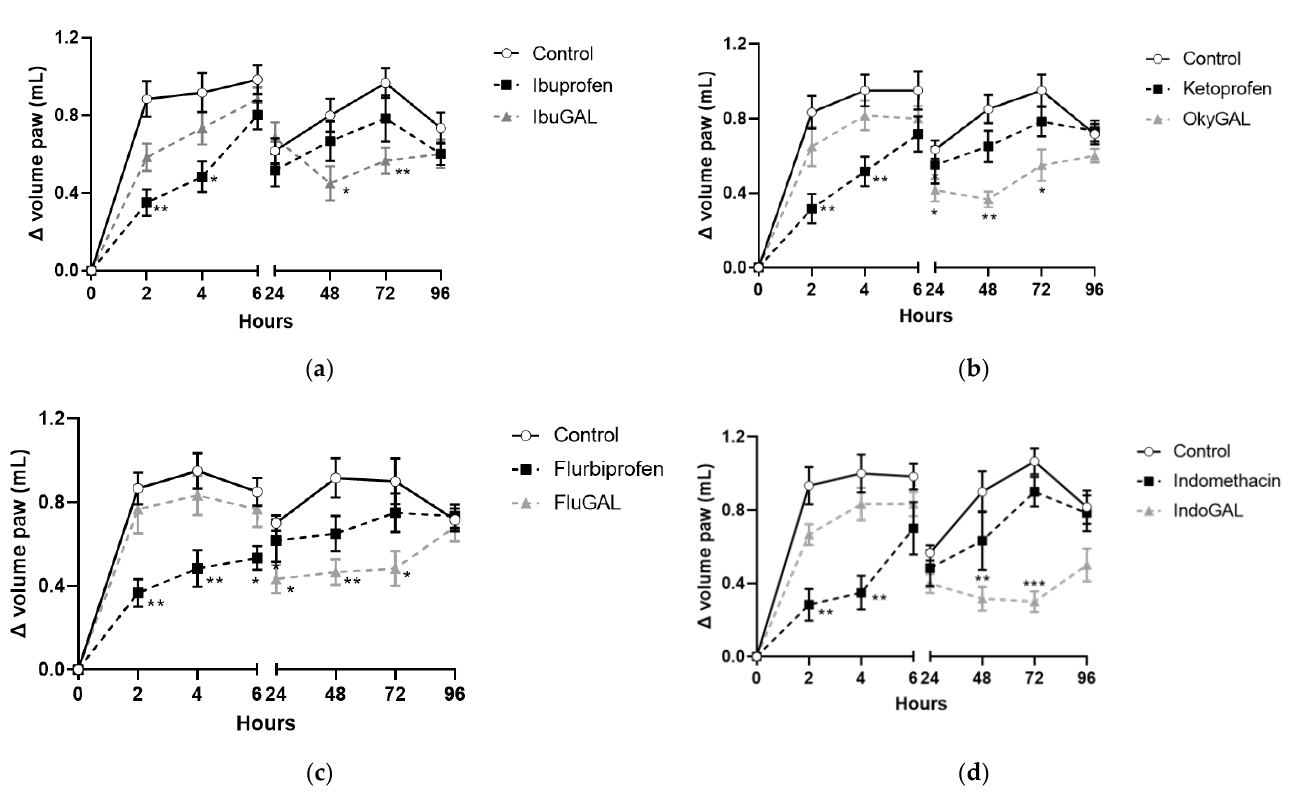
Figure 4. ( a – d ) . Effect of the parent drugs and galactosylated prodrugs on carrageenan-induced hyperalgesia. Effect of oral administration of the parent drugs ( a ) ibuprofen, ( b ) indomethacin, ( c ) ketoprofen and ( d ) flurbiprofen and the galactosylated prodrugs ( a ) IbuGAL, ( b ) IndoGAL, ( c ) OkyGAL and ( d ) FluGAL on carrageenan-induced hyperalgesia in mouse paws evaluated at 2, 4, 6, 24, 48, 72 and 96 h after the carrageenan challenge. White circles represent control mice treated with vehicle. Black squares represent mice treated with the parent drugs (ibuprofen, indomethacin, ketoprofen, and flurbiprofen) and gray triangles represent mice treated with the galactosylated prodrugs (IbuGAL, IndoGAL, OkyGAL and FluGAL). The increase in paw volume was evaluated and is expressed as the difference in paw volume measured at each time point and the basal paw volume measured immediately before carrageenan injection. Data are expressed as means ± S.E.M.